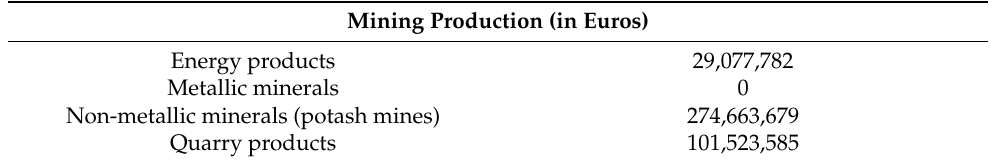
Table 1. Mining production in Catalonia in 2016. Source: Statistical Institute of Catalonia with data from the Ministry of Energy, Tourism and Digital